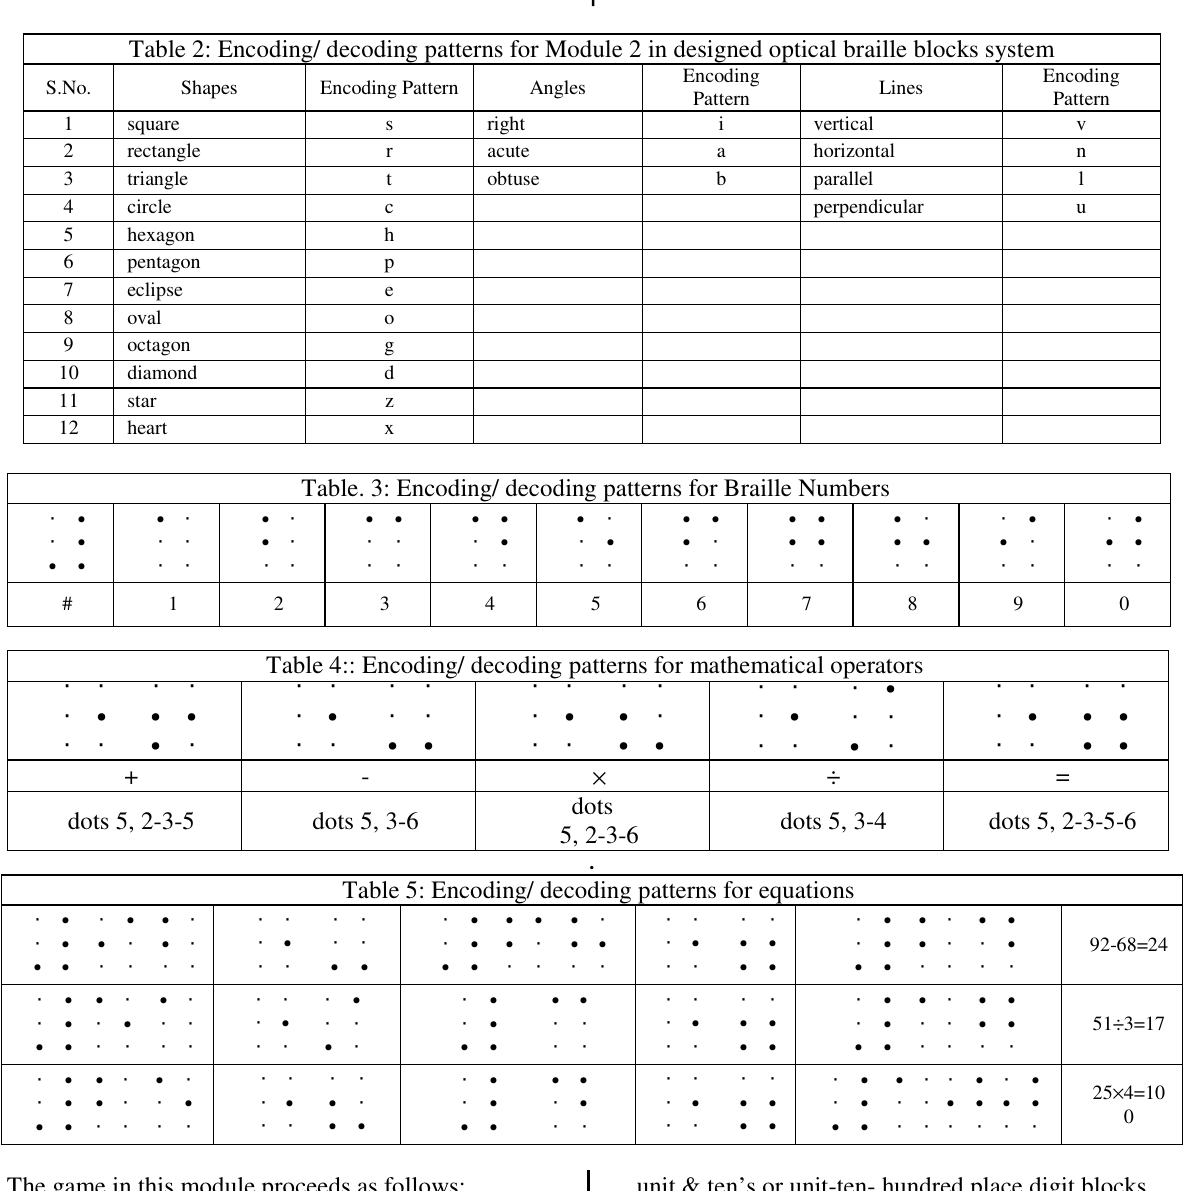
Table 5: Encoding/ decoding patterns for